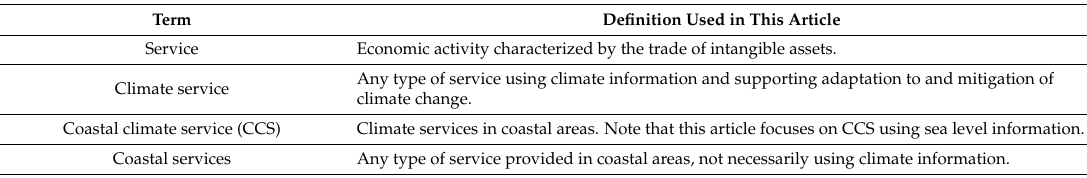
Table 1. Terms used in this article and their